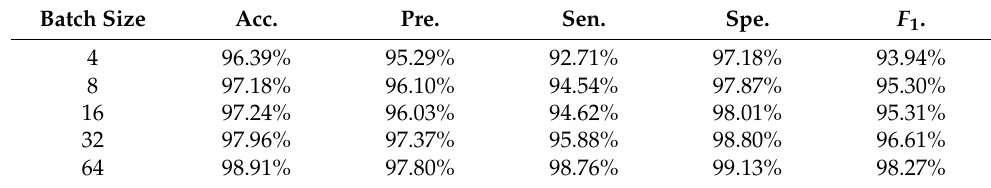
Table 11. Classification results of different batch sizes on the COVID-19 Radiography database. Batch Size Acc. Pre. Sen. Spe. F 1 . 96.39%